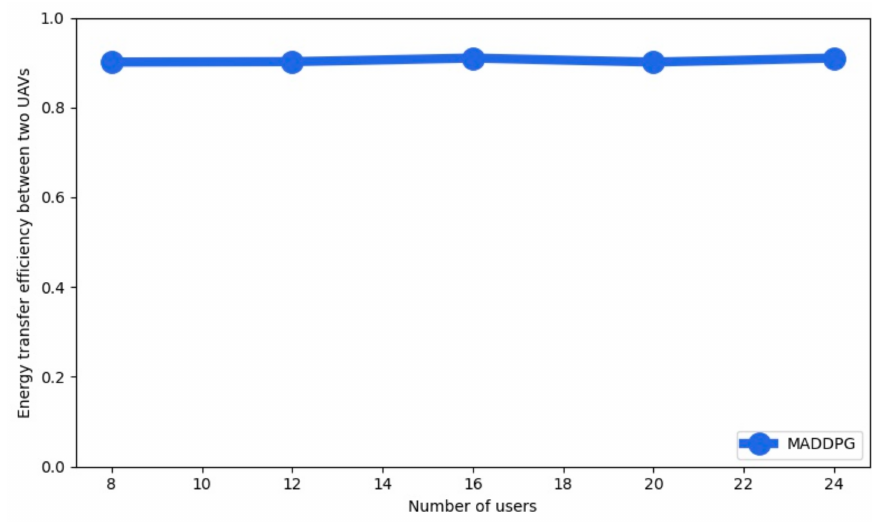
Figure 6. Energy transfer efficiency as a function of the number of users.